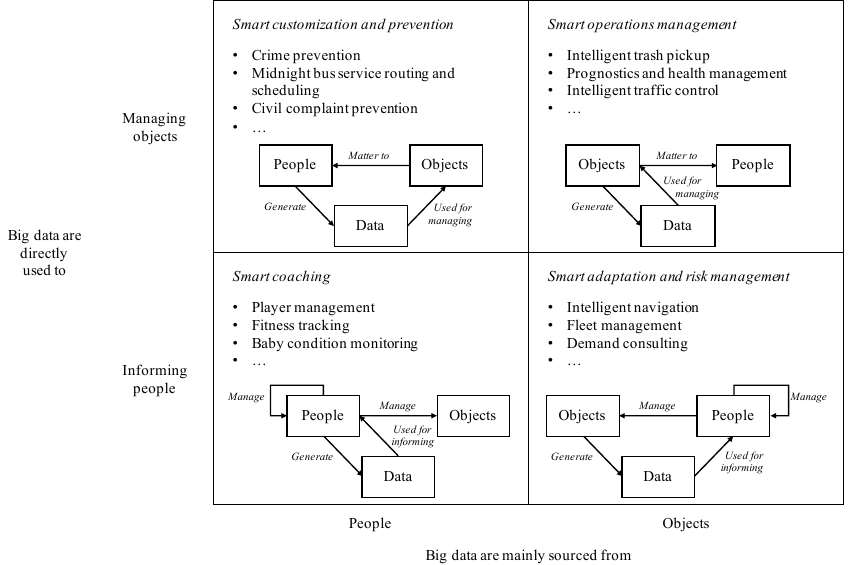
Fig. 1. Four ways to use big data in smart service